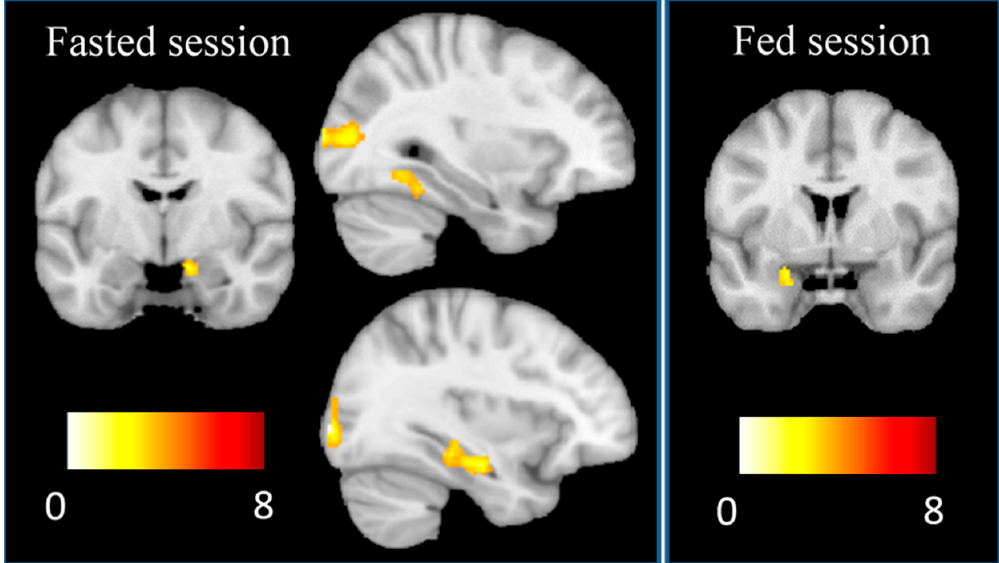
Figure 2. Increased brain activation to “high-calorie vs low-calorie” foods during the fasted and the fed sessions. Right side of the figure corresponds to the right hemisphere in the coronal views. In sagittal views, the upper figure corresponds to the right hemisphere, whereas the lower figure corresponds to the left hemisphere. Colour bar displays t-values for the comparison of activation in response to high-calorie vs low-calorie food cues.